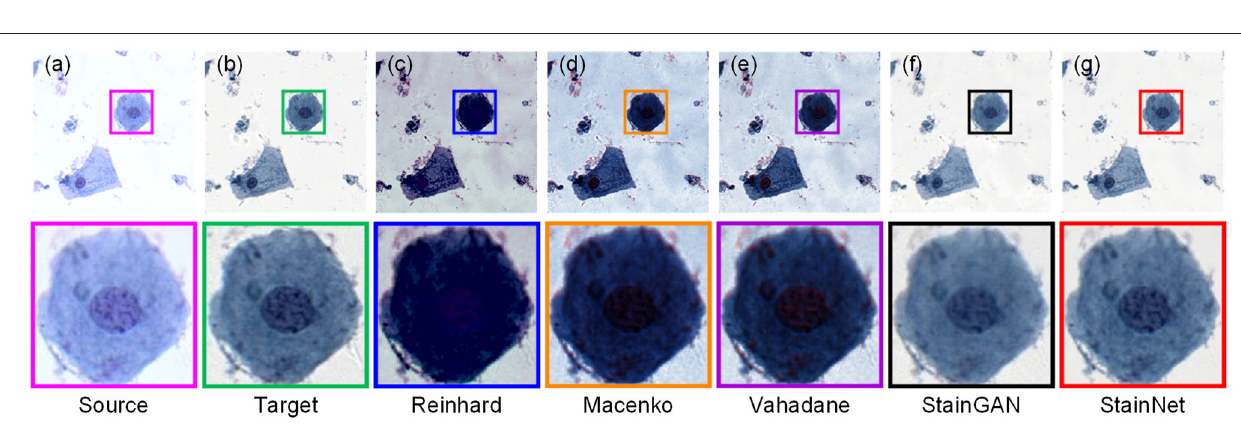
and normalized images are shown in Figures 3d,h . The gray value profiles of the normalized images by StainNet and the target images coincide on the whole indicating that, after being normalized by StainNet, the normalized images have